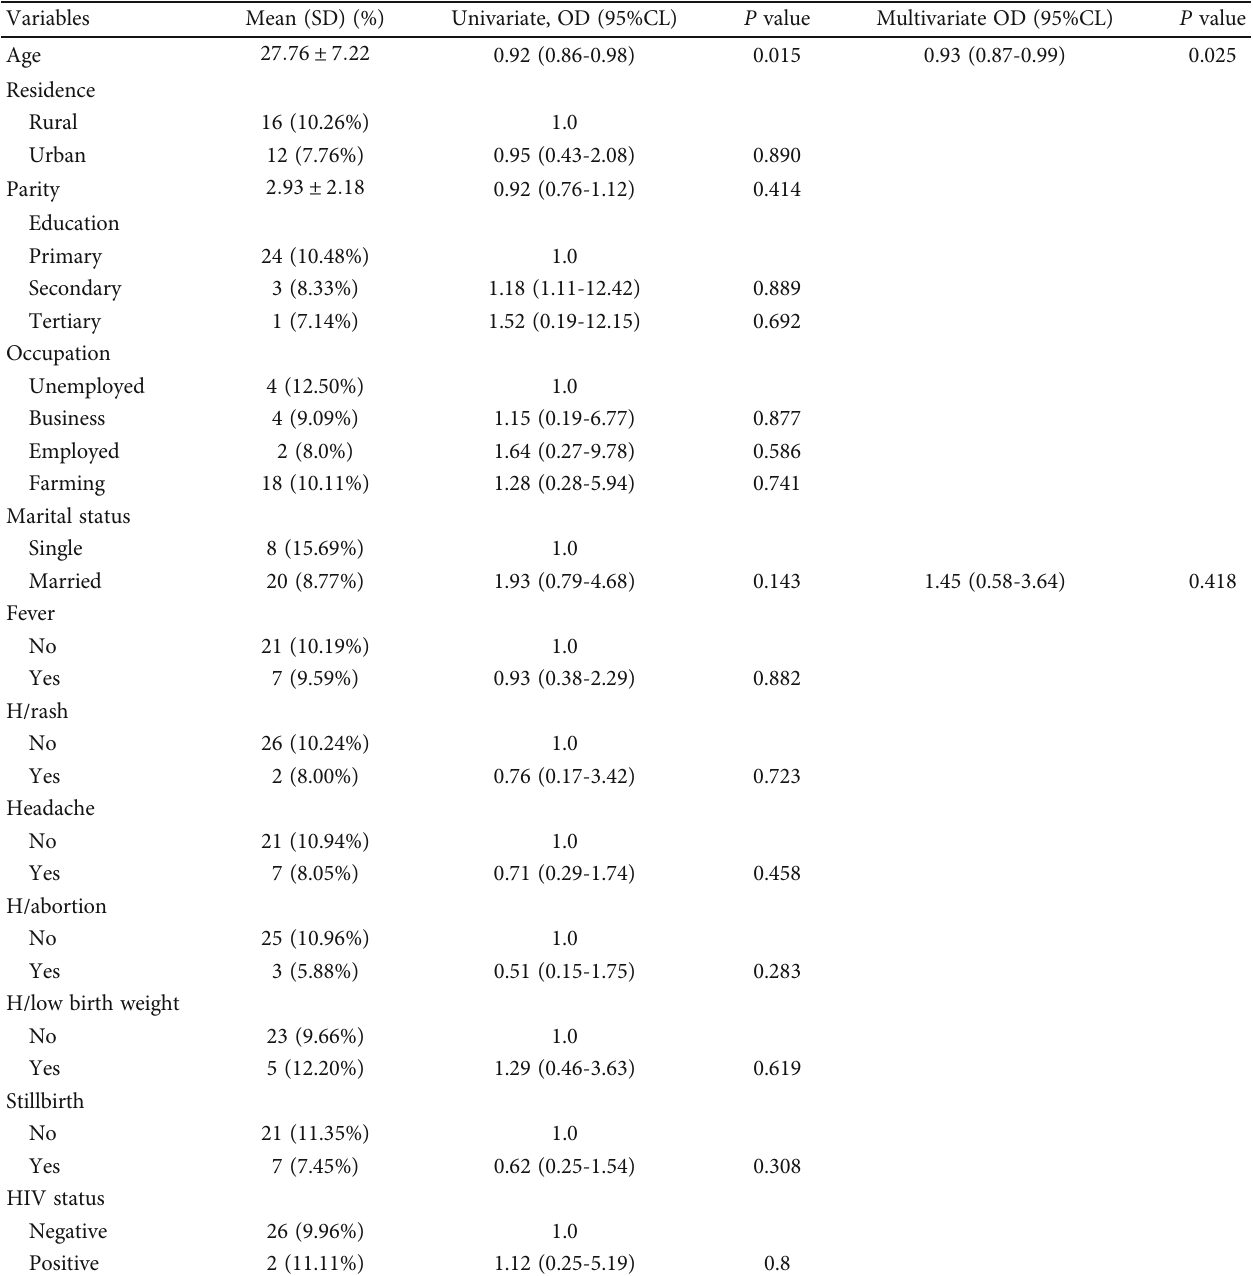
Table 3: Univariate and multivariate logistic regression analyses of the factors associated with HSV-2 IgG seropositivity among 279 women with stillbirth in Mwanza,